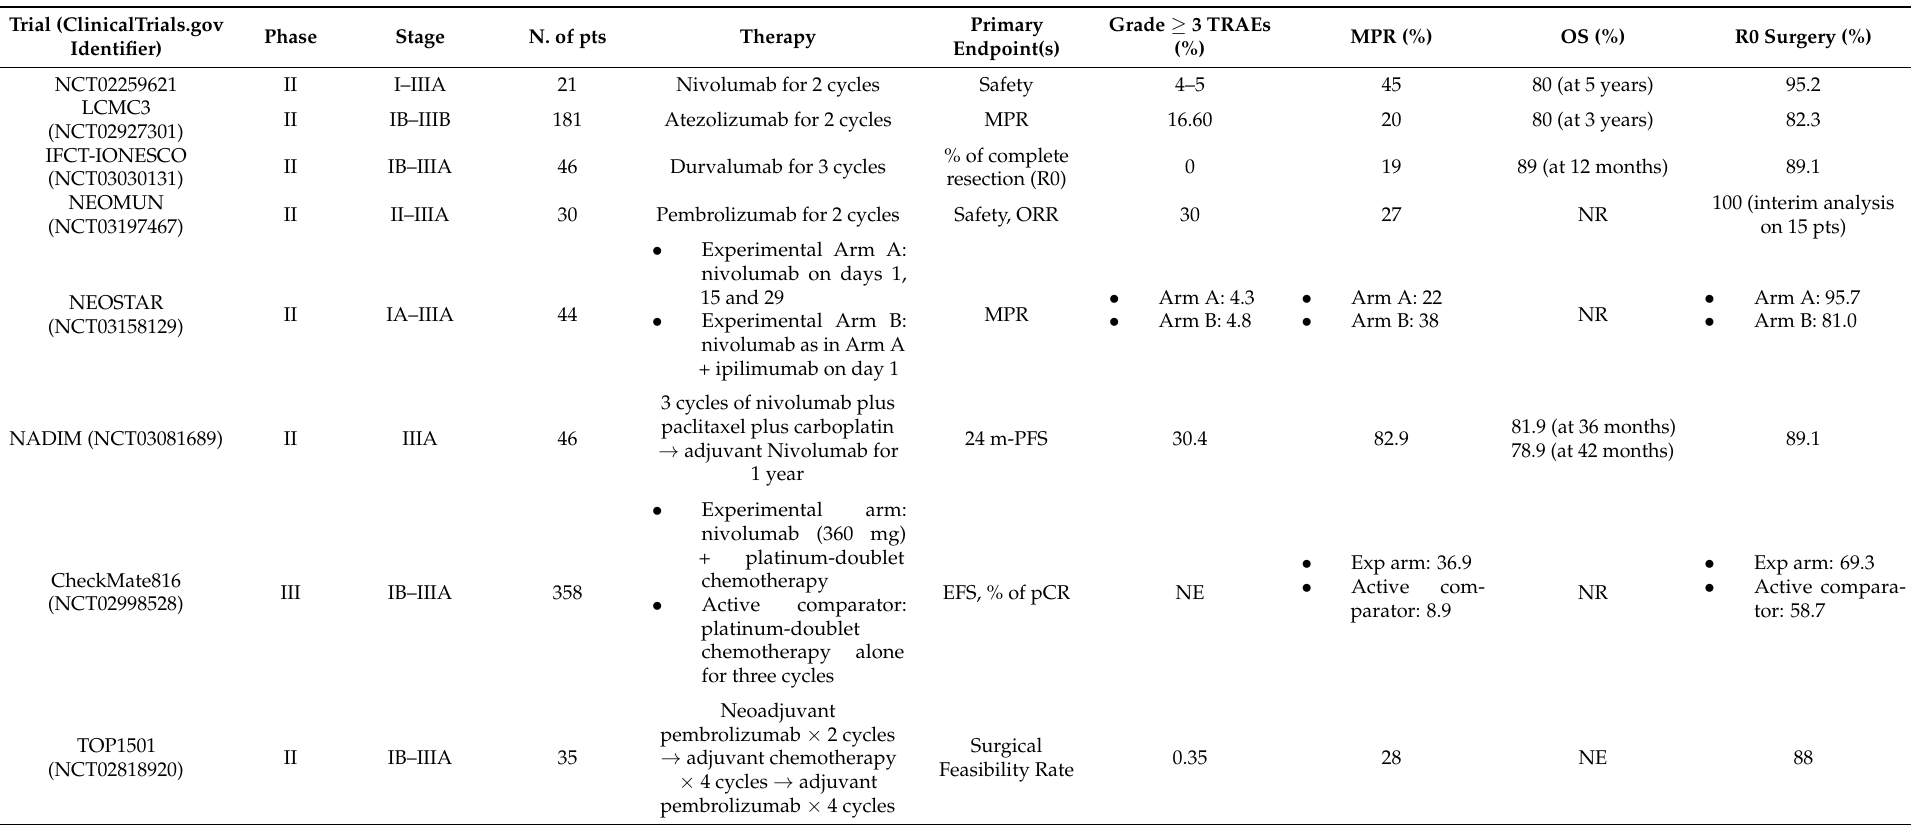
Table 1. Neoadjuvant immunotherapy in